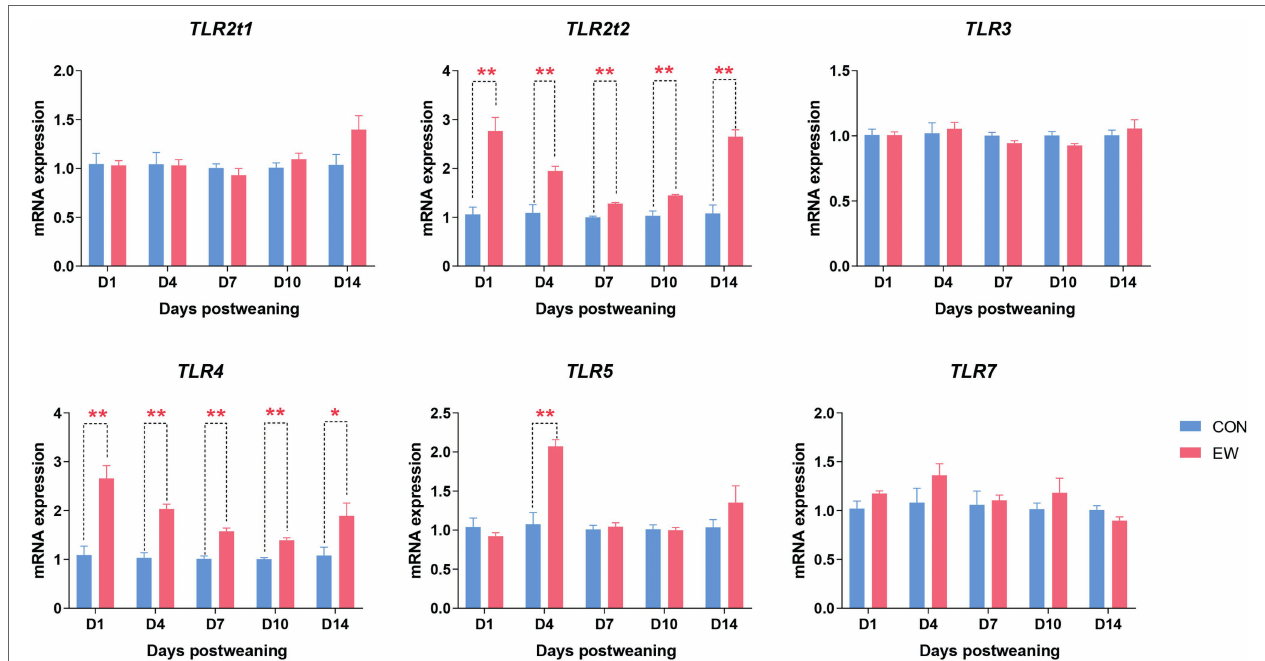
FIGURE 9 | Effects of early weaning on mRNA expression of toll-like receptors (TLR) in the ileum of squabs. D1, D4, D7, D10, and D14 means 1, 4, 7, 10, and 14 days postweaning, respectively. Values are means with their standard errors of eight squabs. * and ** mean p < 0.05 and p < 0.01, respectively, within each time points postweaning. CON, control group; EW, early weaning